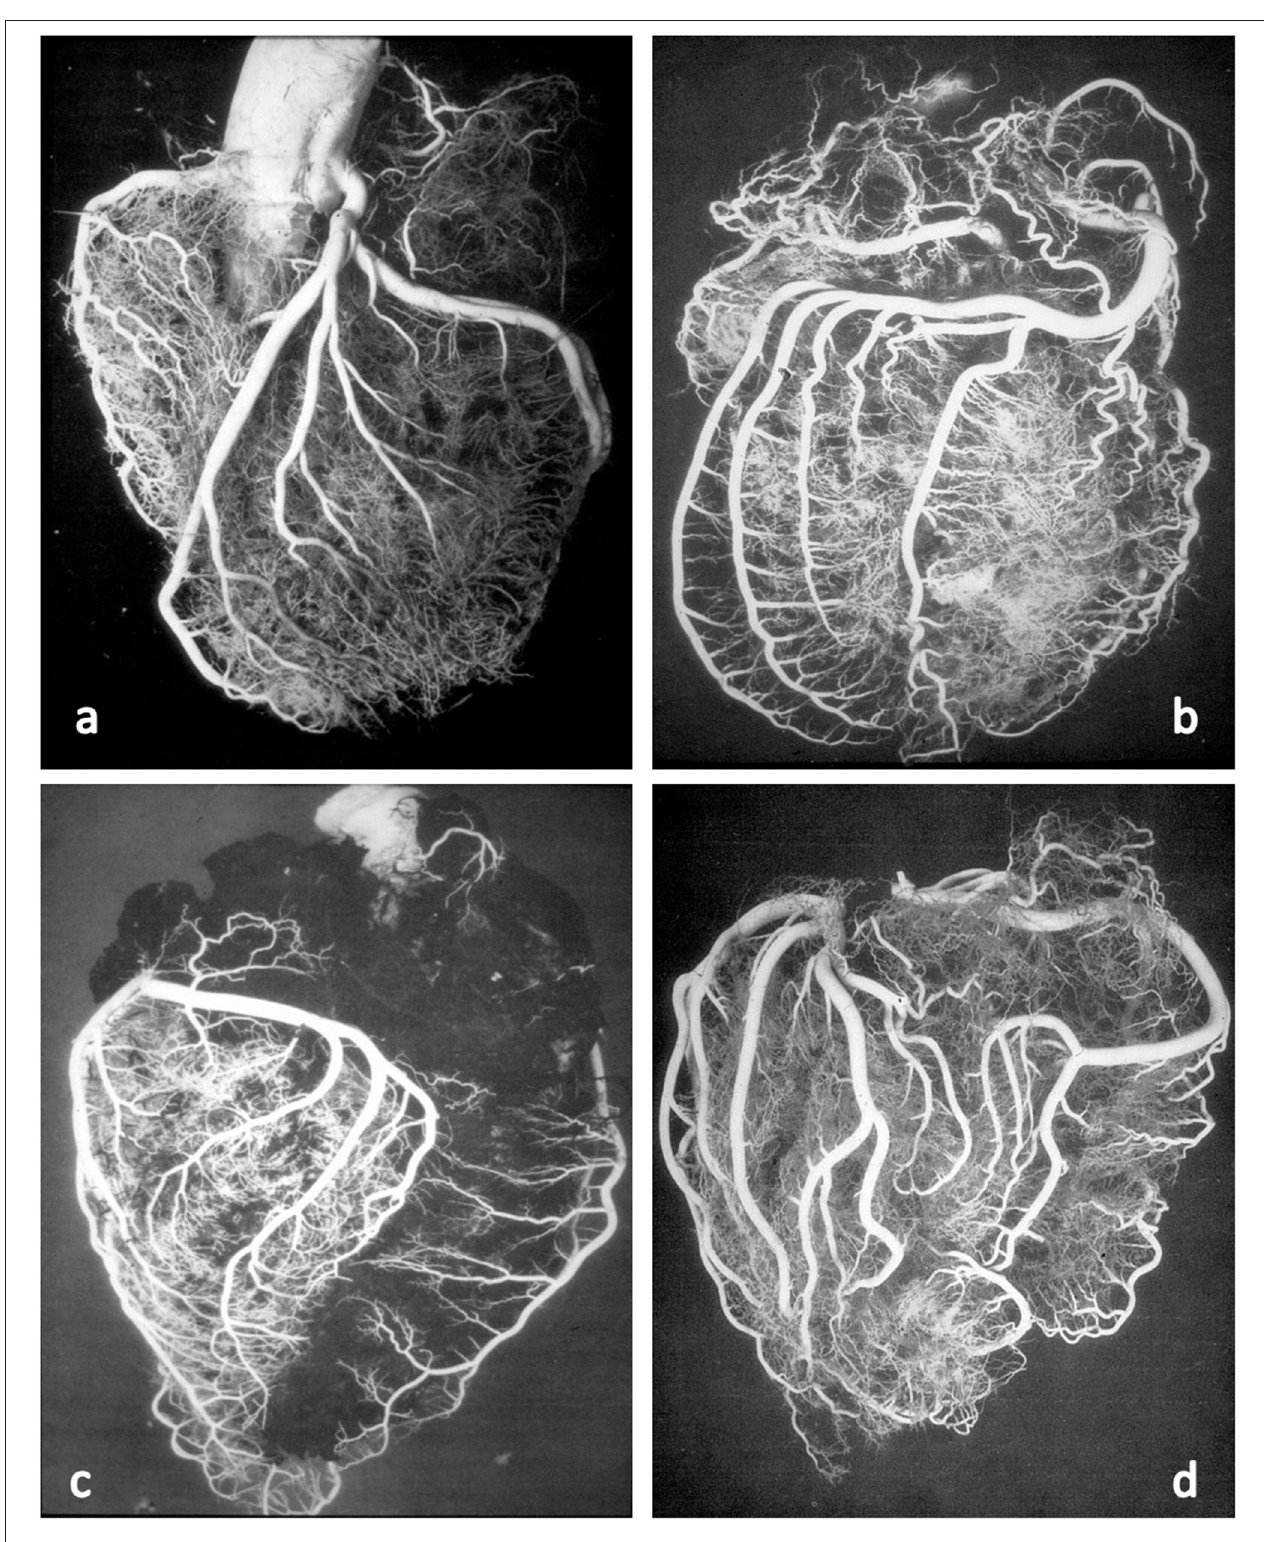
FIGURE 2 | Postmortem casts of coronary arteries. From Baroldi and Scomazzoni (3). (a) Left coronary artery anatomy, (b) dominant right pattern, (c) dominant left pattern, and (d) balanced pattern.